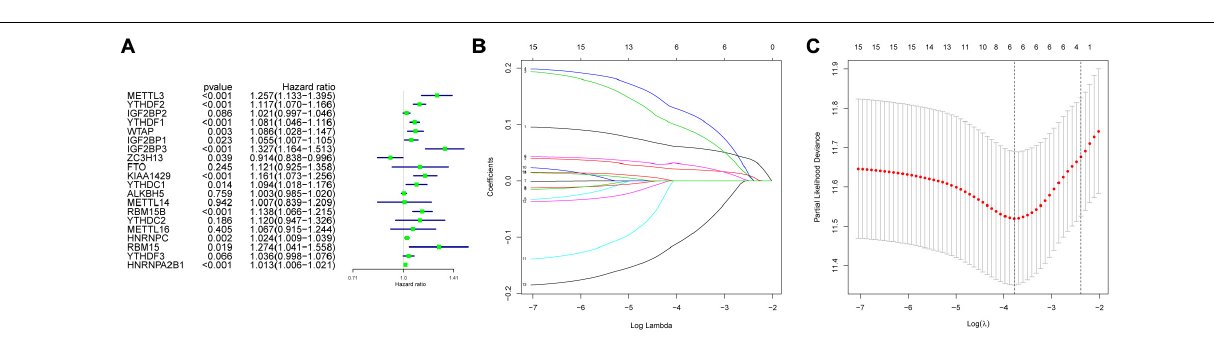
FIGURE 6 | Screening of variables. (A) The hazard ratios (HR) and 95% confidence intervals (CI) of 20 m6A modification regulators in LIHC was computed by univariate Cox regression. In the 15 genes, high correlation genes were chosen and shrunk to prevent over-fitting (B,C) and finally produced a six-gene signature in LASSO regression. LIHC, liver hepatocellular carcinoma; LASSO, least absolute shrinkage and selection